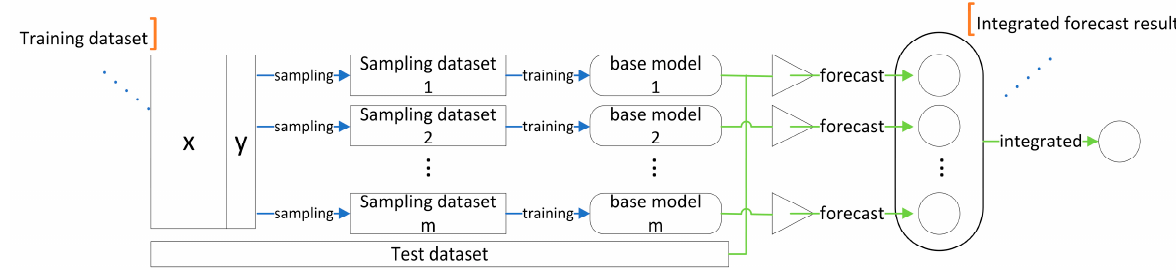
Figure 1. Description of bagging principle.